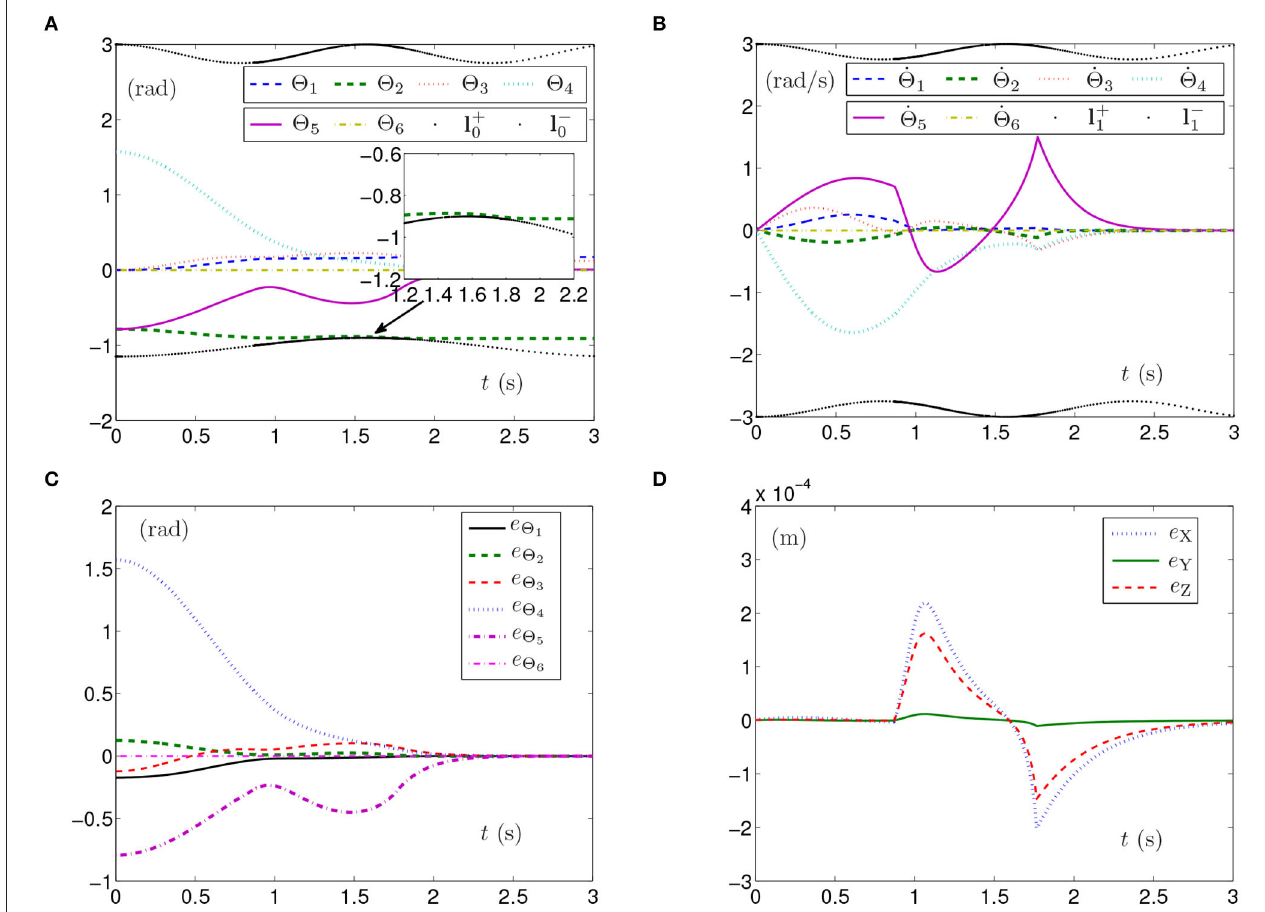
FIGURE 9 | Synthesized results of PUMA560 manipulator using SMCSvZ with time-varying physical limits verged. (A) Profiles of joint angles. (B) Profiles of joint-angle velocities. (C) Profiles of joint-angle errors. (D) Profiles of end-effector position errors.